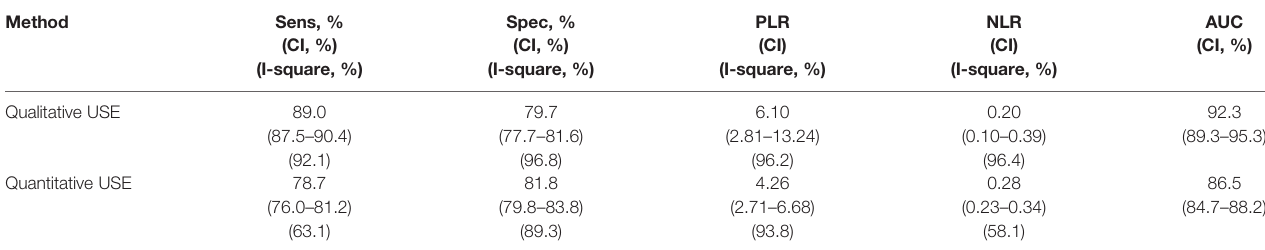
TABLE 6 | Pooled diagnostic performance of qualitative USE using only retrospective